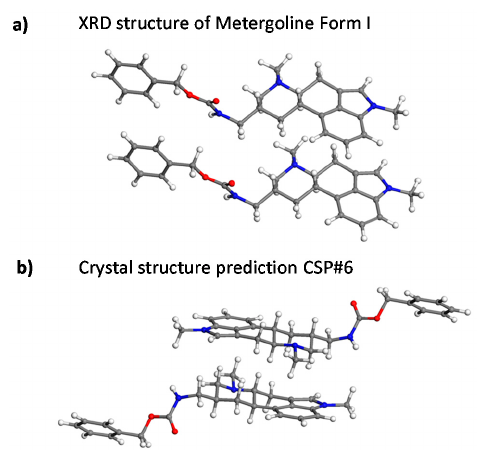
Figure 7. A typical fragment of molecular packing in crystalline Metergoline Form I ( MI ) as determined by XRD analysis ( a ), and the corresponding fragment found in the crystal structure prediction CSP#6 ( b ).